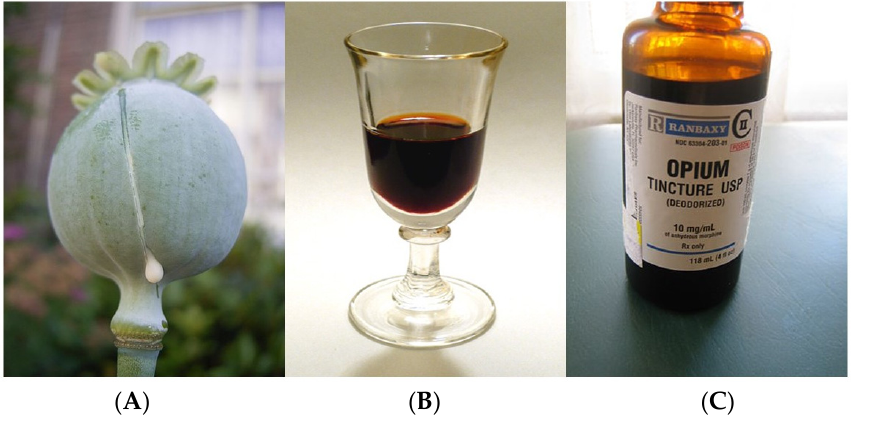
Figure 2. ( A ) Opium poppy seed pod exuding latex from a cut is mixed with alcohol ( B ) to make Laudanum ( C ) known as Opium Tincture. Photographs are public domain.